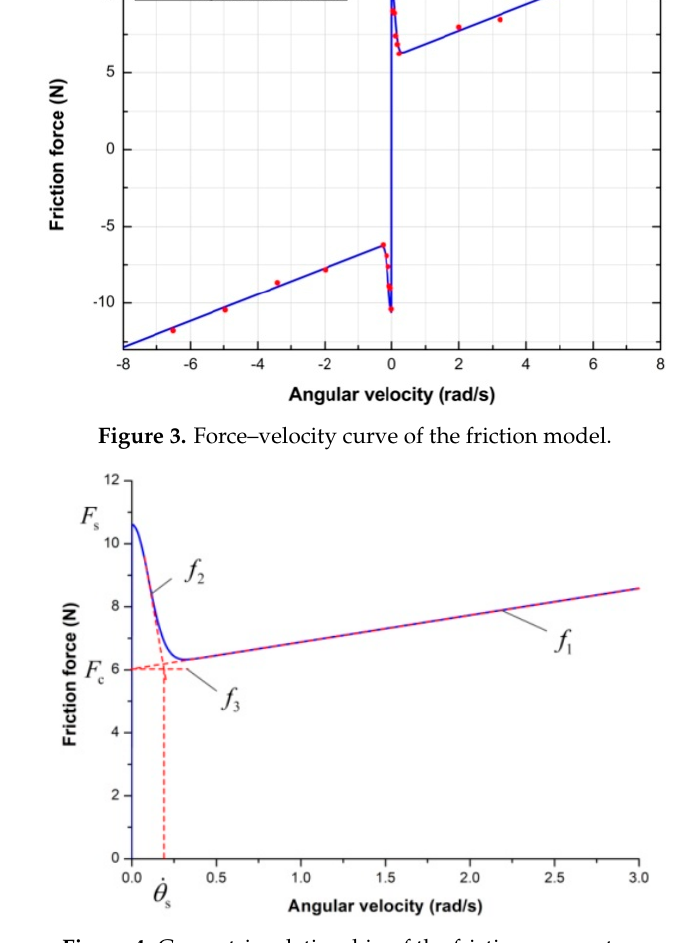
Figure 4. Geometric relationship of the friction parameters. Table 2. Values of the friction parameters.